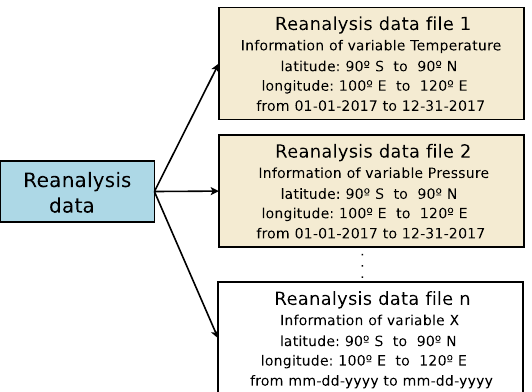
Figure 11. Example of entering two reanalysis data